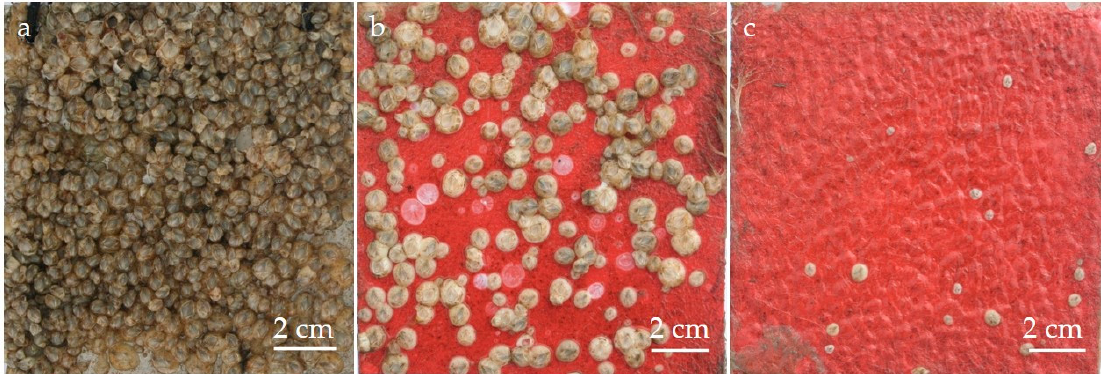
Figure 4. Adhesion of barnacles to surfaces after 12 weeks of exposure to the North Sea (after cleaning). ( a ) V2A-steel reference, ( b ) silicone mixture with Poraver particles and ( c ) silicone mixture with